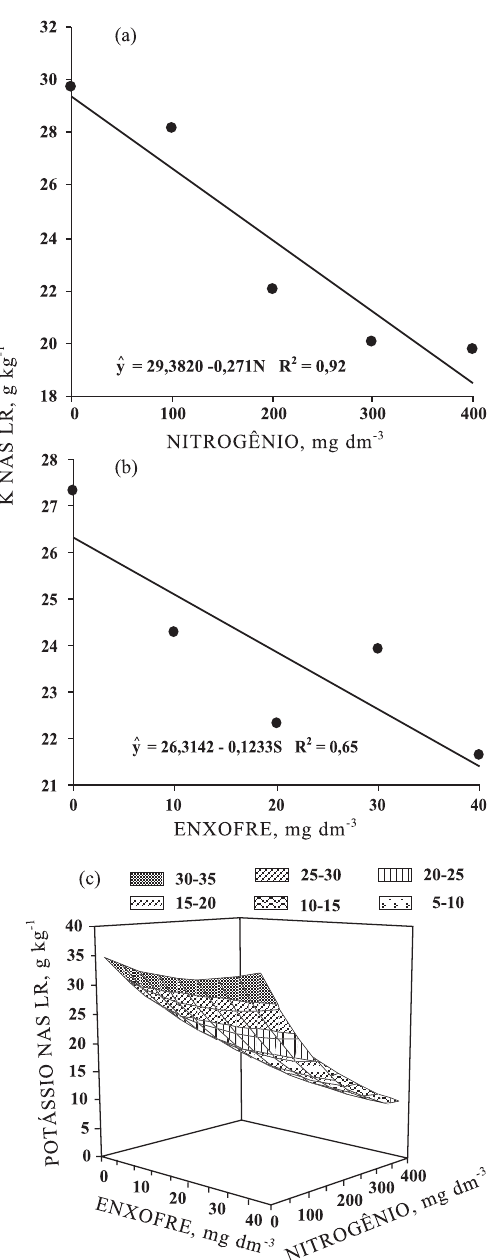
Figura 1. Teor de potássio nas lâminas de folhas re- cém-expandidas (LR) do capim-marandu em função das doses de nitrogênio (a) e de enxofre (b) no primeiro e segundo cortes, respectiva- mente, e em função das combinações de doses de nitrogênio e de enxofre no terceiro corte